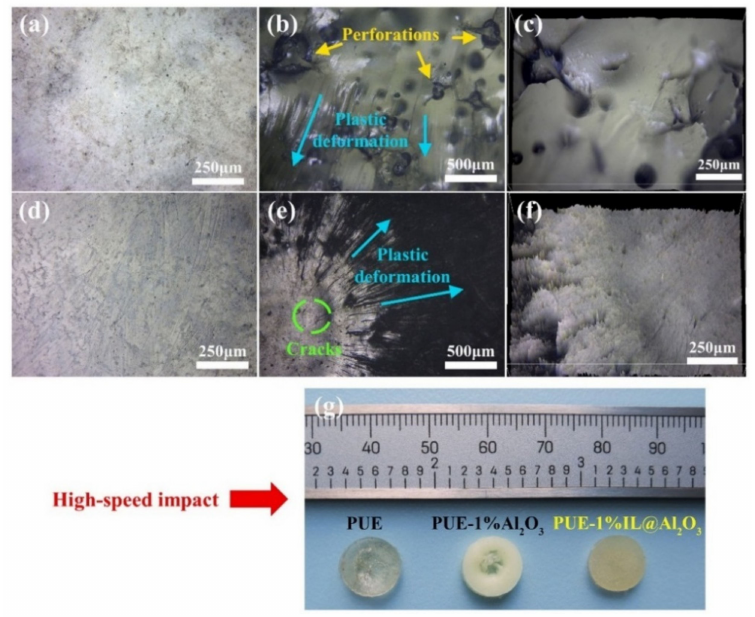
Figure 7. The pictures ( a , b , d , e ) show the damaged surfaces via optical microscopy; and ( c , f ) are the 3D images of the damaged surfaces. The pictures are of PUE ( a – c ) and PUE-1%IL@Al 2 O 3 ( d – f ). The samples before the impact ( a , d ) and after impact ( b , c , e , f ). The picture of ( g ) is the sample’s appearance after